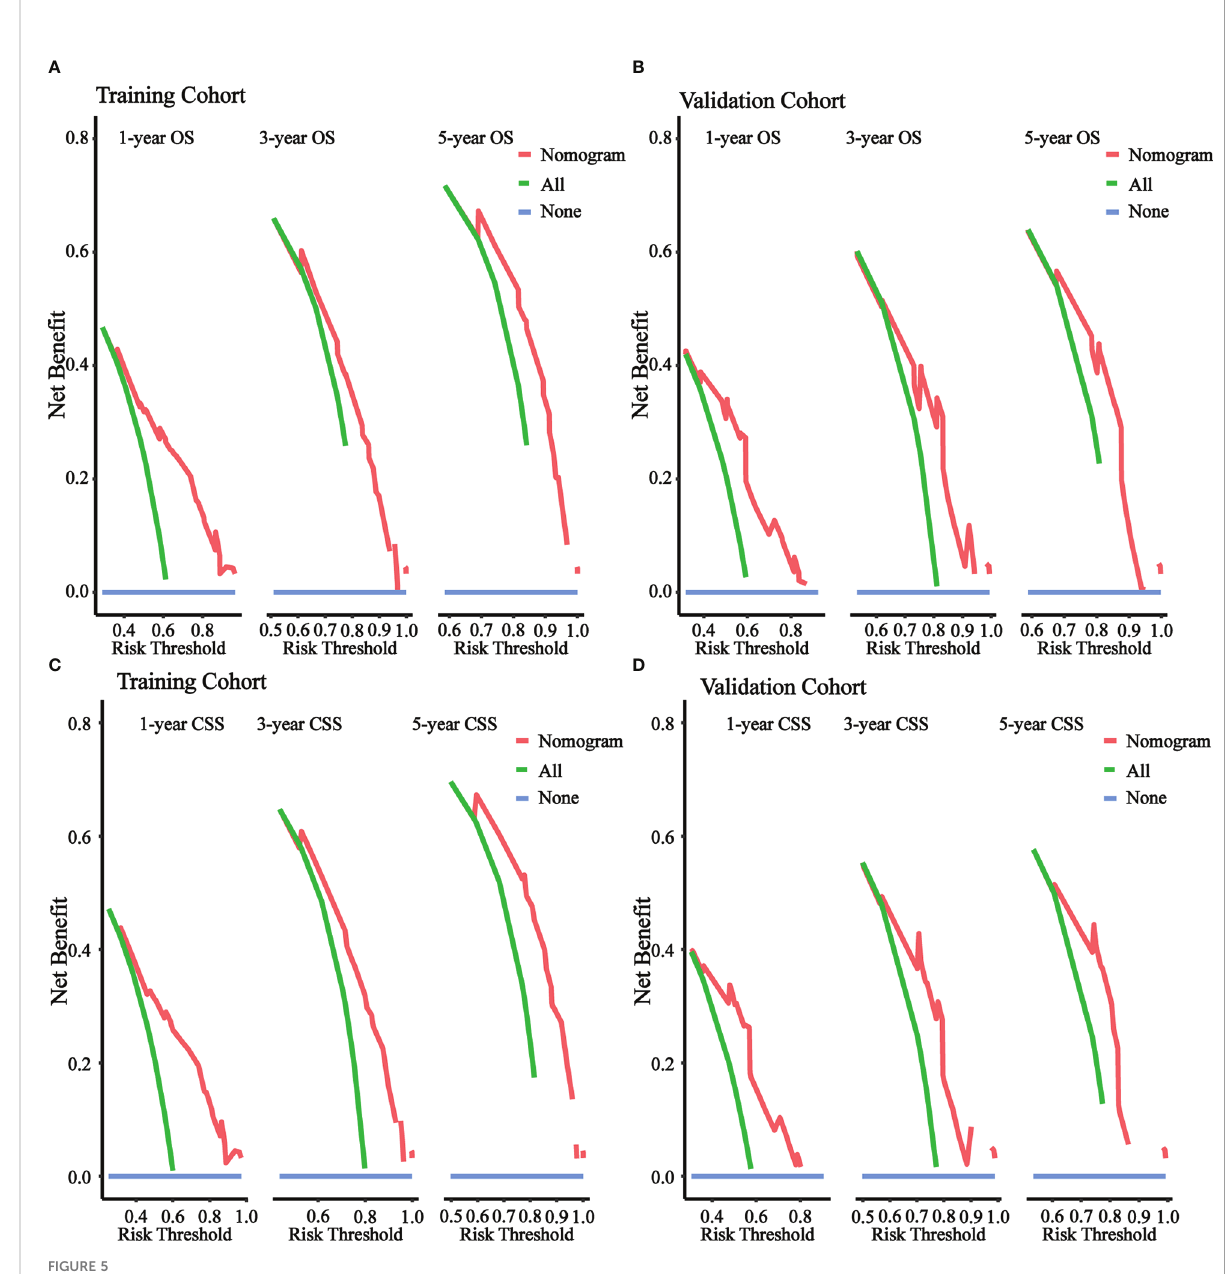
FIGURE 5 DCA of the nomograms to predict OS and CSS. (A) DCA of the nomogram to predict OS at 1-, 3-, 5-year in training cohort. (B) DCA of the nomogram to predict OS at 1-, 3-, 5-year in validation cohort. (C) DCA of the nomogram to predict CSS at 1-, 3-, 5-year in training cohort. (D) DCA of the nomogram to predict CSS at 1-, 3-, 5-year in validation